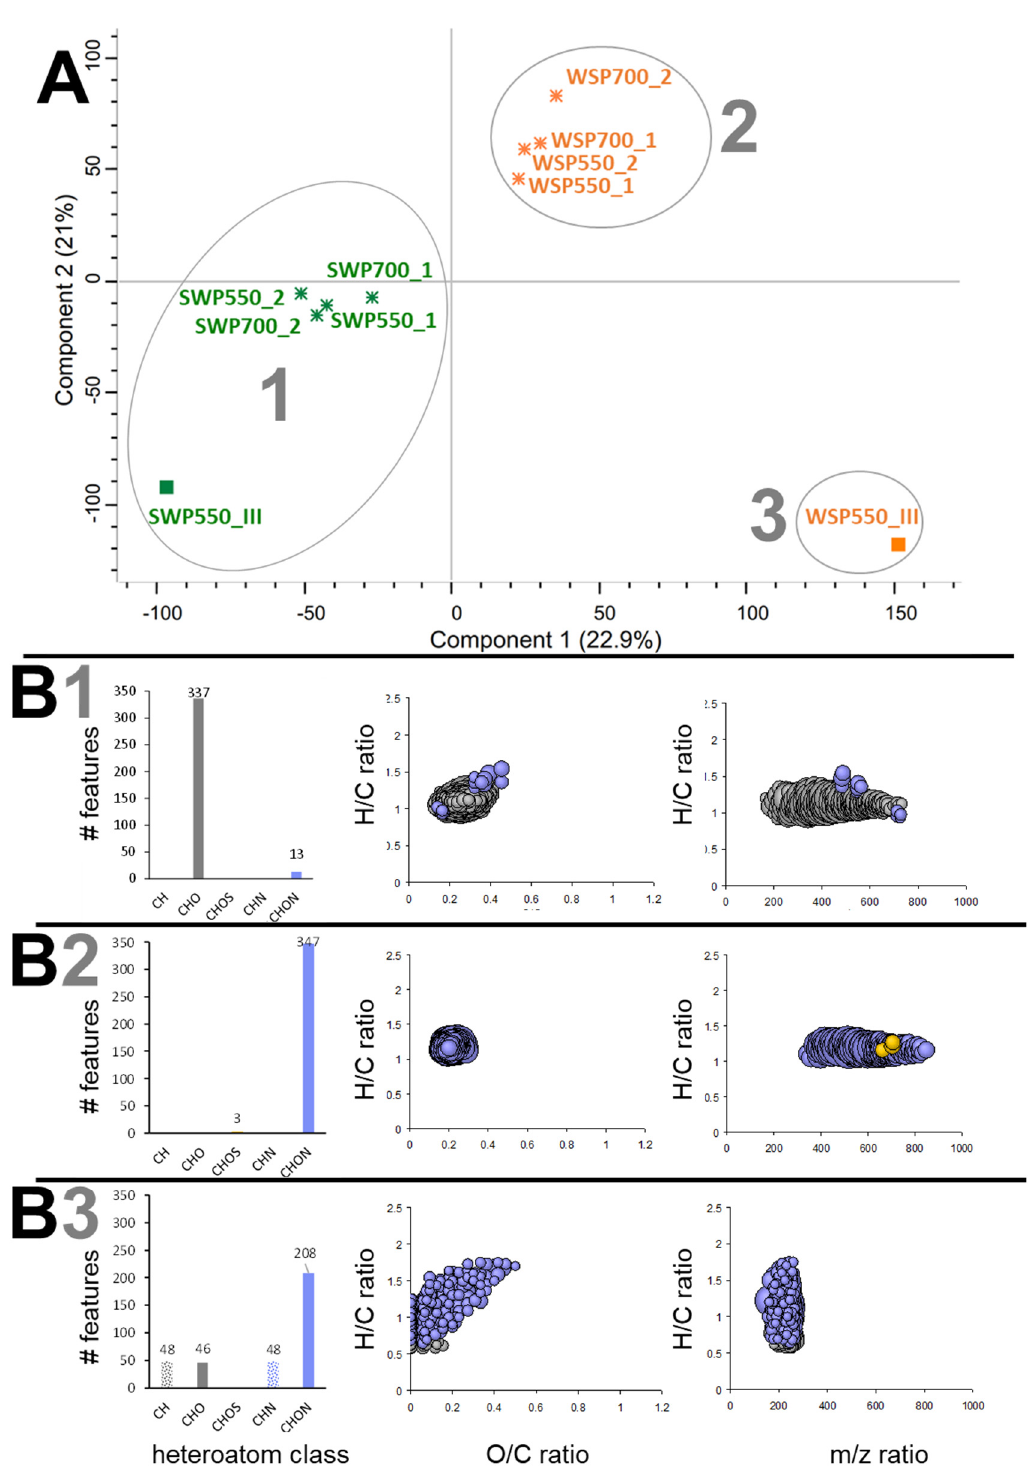
Figure 4. ( A ) Principal component analysis (PCA) score plot of all m/z features from bio-oils measured by APPI (+) FTICR MS. Wheat straw pellets-derived bio-oils in orange, softwood pellets bio-oils in green, small-scale unit bio-oils highlighted by a star and pilot-scale bio-oils by a full square. ( B ) Two hundred features specific to group 1, 2 and 3 observed in panel ( A ) were extracted and represented as (from left to right) bar chart according to their heteroatom classes, van Krevelen diagram (O/C vs. H/C) and m / z vs. H/C-ratios. The bubble size is relative to peak intensity.